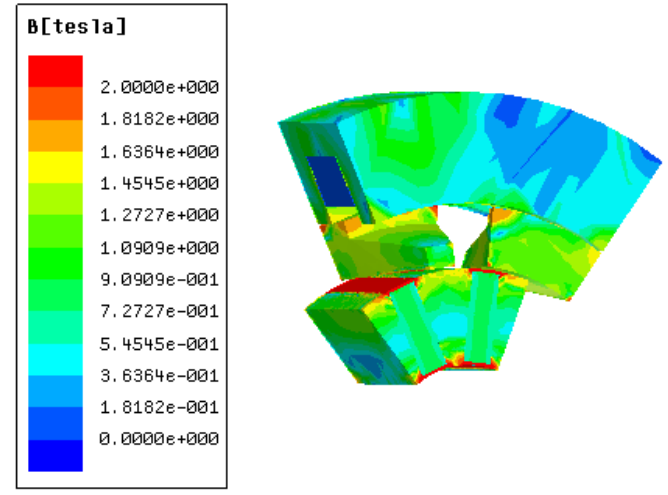
Figure 4. No-load flux density distribution at maximum linked flux.